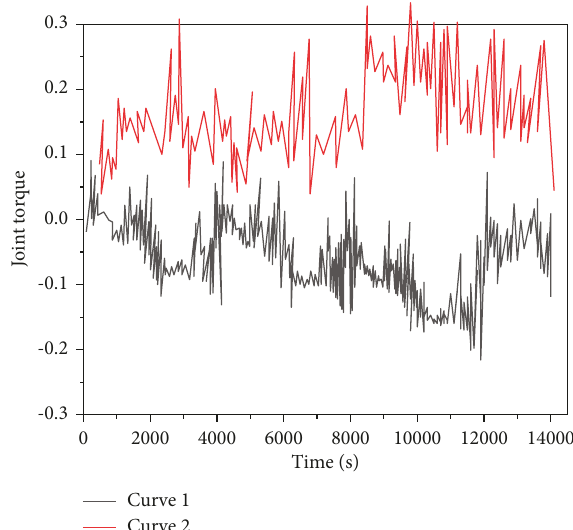
Figure 6: Experimental results of inspection robot joint